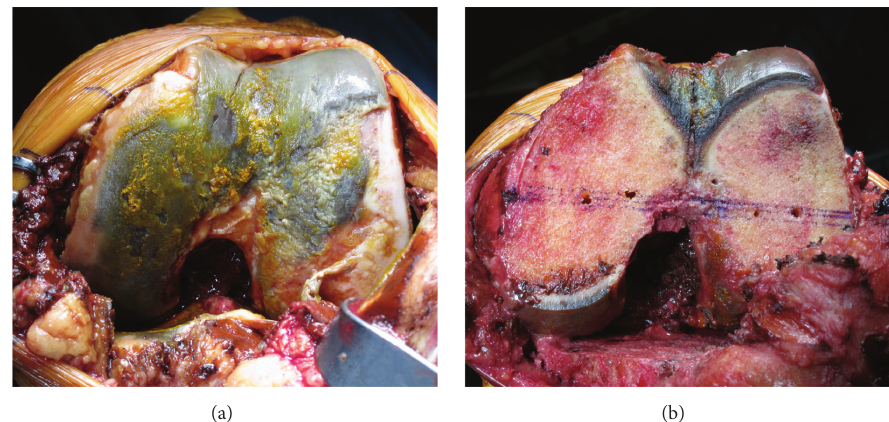
Figure 2: Surgical findings. (a) Macroscopic findings during total knee replacement reveal that the femoral and tibial articular cartilage exhibit brown, grey, and black pigmentation and that the synovial membranes also exhibited reddish-brown discolouration. (b) After cutting the distal femur, we observed that only the joint surface cartilage, not the subchondral bone, exhibited the black colouration.